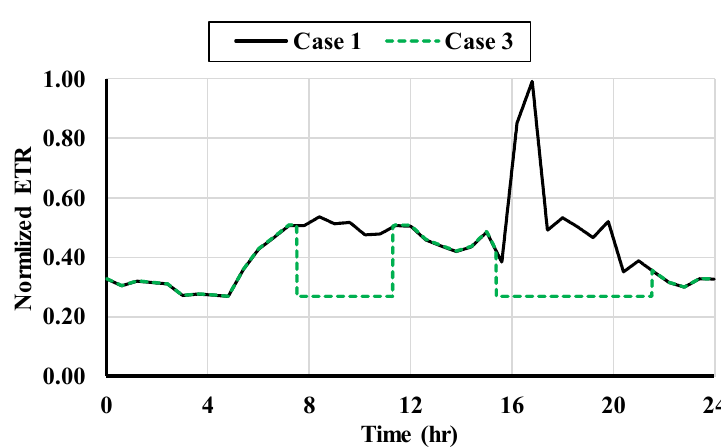
Figure 14. Impact of the wind integration on ETR.